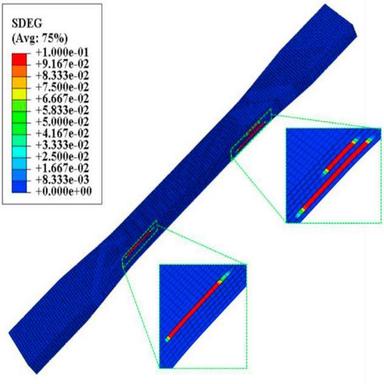
Comparison of fracture locations from the simulation and the experiment.